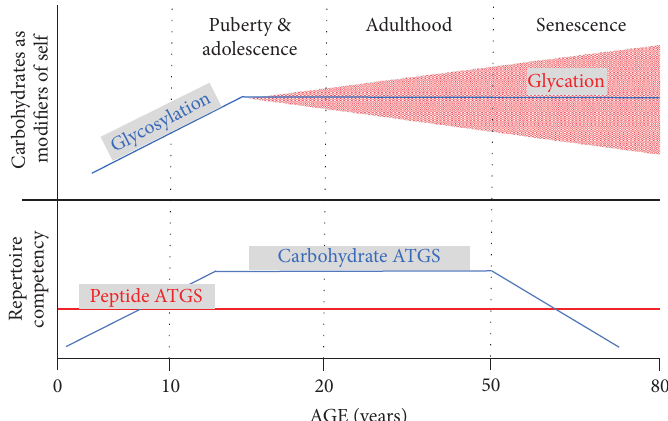
Figure 1: Concomitance of the age-related changes in glycosylation and glycation patterns with the age-related repertoire competency expansionandcontraction/attrition.Competencyforpeptideantigensdevelopsearlyinlifeandpersiststhroughoutlife.Incontrast,repertoire for carbohydrate antigens develops gradually. It parallels the growth- and maturation-induced glycosylation of self (first ∼ 15 years of life), to which theprominently active thymus during that period of life responds with an output of carbohydrate-responsive repertoire. That repertoire contracts later in life, paralleling increased alterations of self due to potentially pathogenic glycosylation and/or glycation processes. Those alterations may be primarily induced by environmental factors (injury, infection, nutrition-induced metabolic abnormalities, etc.) and may result in repertoire